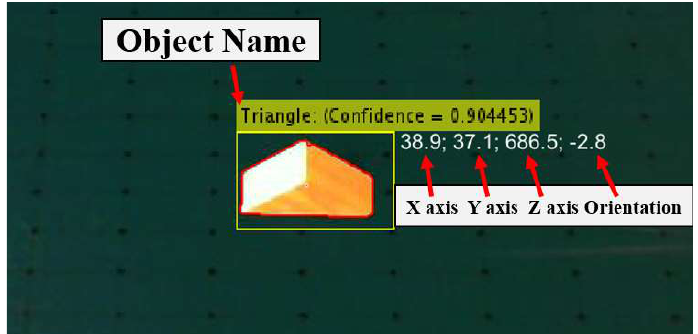
Figure 13. Object name and location and their orientation estimation results.